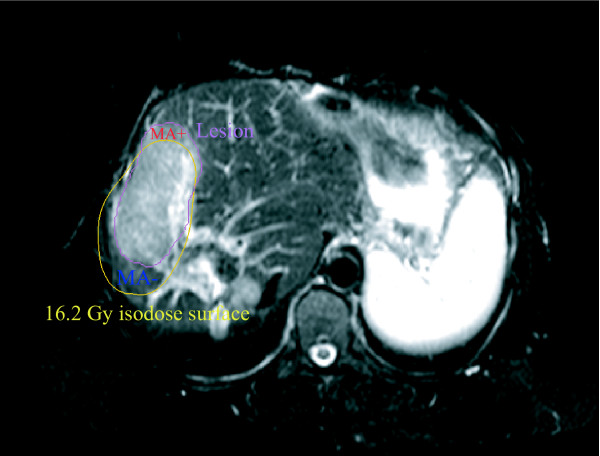
Mismatch areas. T2-w image showing segmented irradiation effect and 16.2Gy isodose encompassing the corresponding tolerance dose volume. A very pronounced shift of the irradiation effect with respect to the isodoses is shown to illus-trate the likely maximum inaccuracy of catheter positioning. Mismatch areas in which we observed a dose response at doses smaller than the tolerance dose of the total irradiation effect are indexed with "MA+" and mismatch areas in which we did not observe a dose response at doses higher than the tolerance dose of the total irradiation effect are indexed with "MA- ".